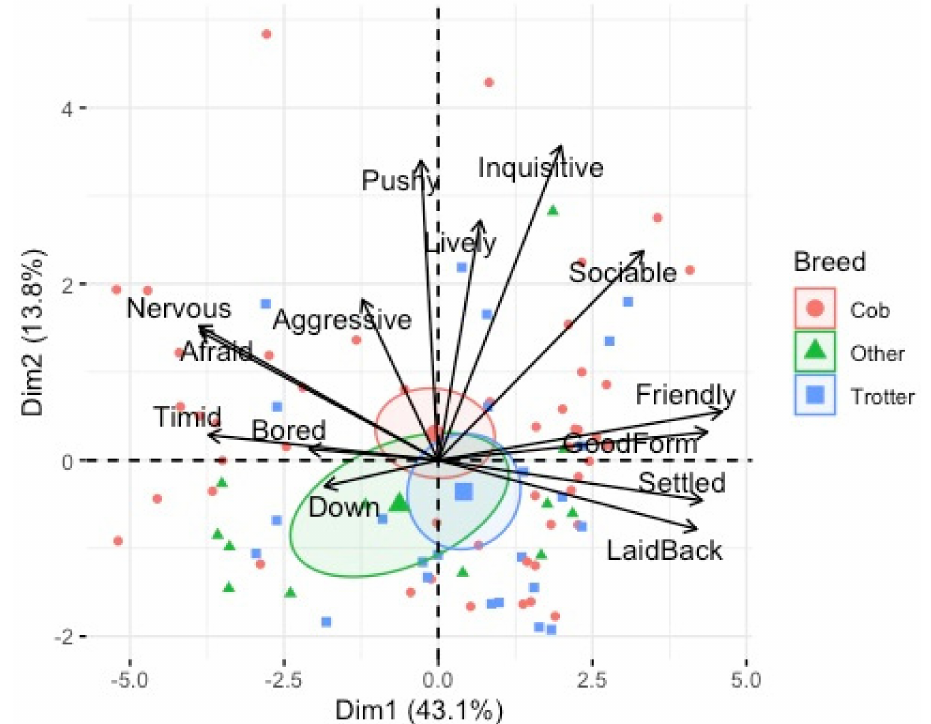
Figure 9. PCA bi-plot of QBA of terms associated with individual horses who were either a Cob, Trotter or other. Dimension 1 (mood) and Dimension 2